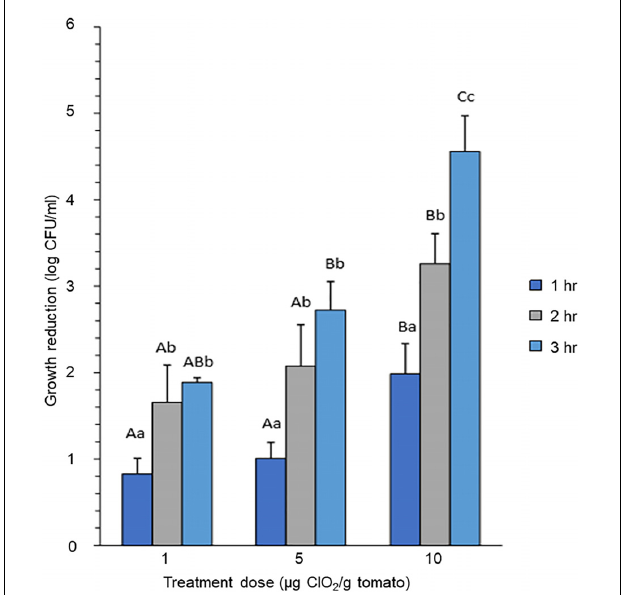
FIGURE 1 | Growth reduction of E. coli on tomato treated with different concentrations of gaseous ClO 2 . Tomato fruits were treated with 1 µ g, 5 µ g, or 10 µ g ClO 2 per gram of ripe berries. Upper-case letters indicate significant difference ( P < 0.05) caused by ClO 2 doses at the same time point. Lower-case letters indicate significant difference ( P < 0.05) caused by time of exposure under the same ClO 2